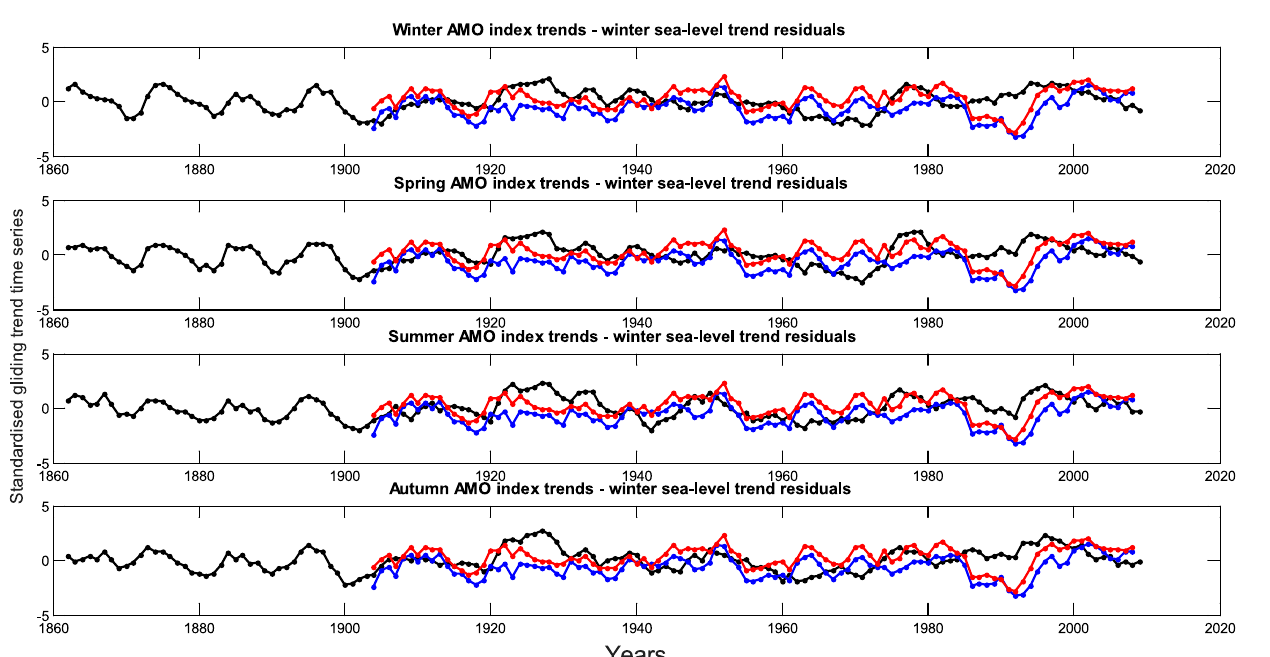
Figure 10. The standardised (unitless) decadal gliding trend time series of the AMO index (black) and tide gauge residuals (blue: Stockholm, red: Warnemünde). Table 1. The correlations of decadal trends between sea level at the Stockholm and Warnemünde stations and area-averaged precipita- tion (PRE) from CRU or NCEP/NCAR in the previous seasons. Additionally, the correlations between decadal trends of freshwater flux (precipitation–evaporation) field means and lagged sea-level trend residuals are shown. The 95% significance levels are r > 0 . 26 for the CRU data set and r > 0 . 19 for the NCEP/NCAR data set. The significant correlation coefficients are marked with an asterisk. Season Station Stockholm